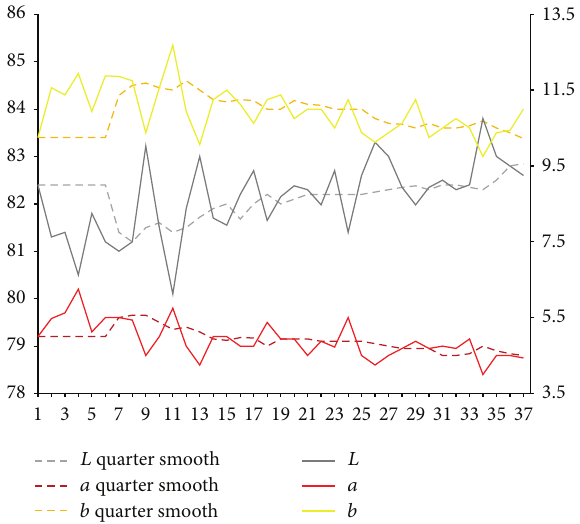
Figure 6: Lab value changing trend of forehead.